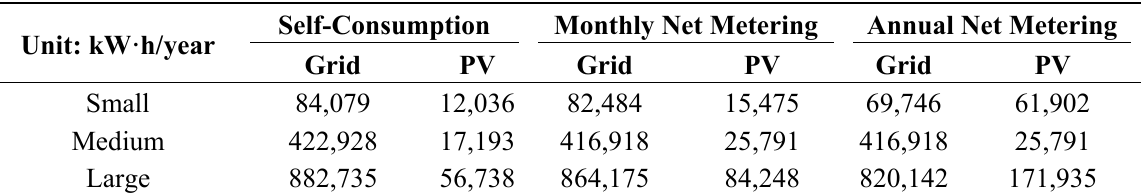
Table 10. Annual electrical consumption.